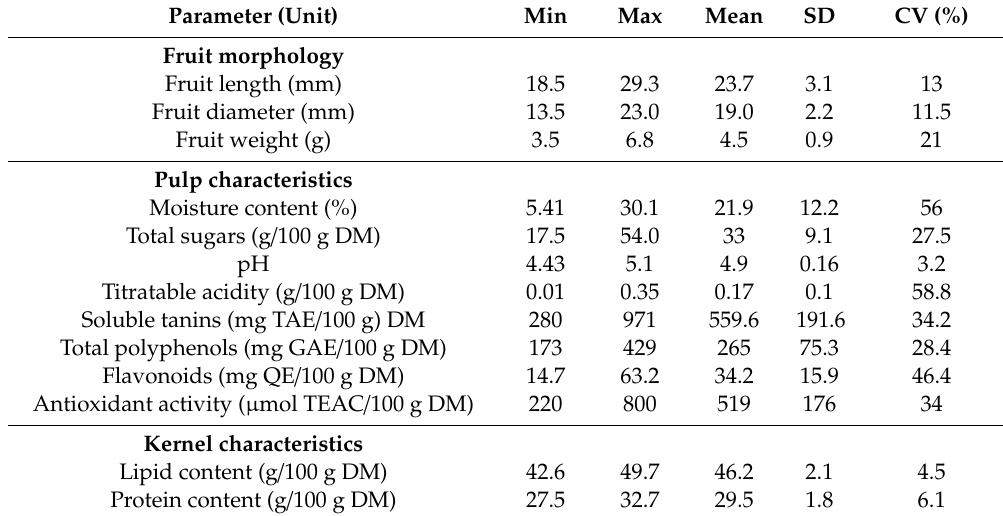
Table 1. Descriptive statistics of 13 physicochemical parameters measured in fruits of 30 Balanites aegyptiaca trees from five locations in Mauritania, Northwest Africa. Parameter (Unit) Min Max Mean SD CV (%) Fruit morphology Fruit length (mm) Fruit diameter